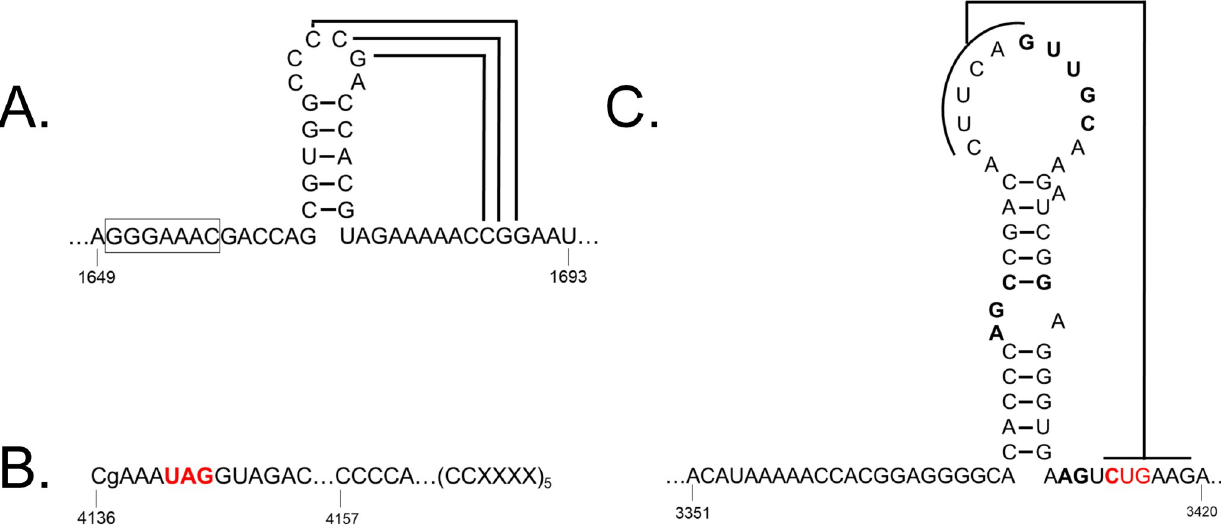
Fig 2. Proposed sites for ribosomal frameshift, ribosomal readthrough, and exoribonuclease-resistant RNA pseudoknot structure for Miscanthus yellow fleck virus. (A) Depiction of potential pseudoknot structure following the “slippery heptanucleotide” sequence (boxed), where ribosomal -1 frameshifting is proposed to occur, connecting open reading frame (ORF) 1 and 2. Drawing was modeled after that presented for sugarcane yellow leaf virus [27]. (B) Sequences flanking the potential readthrough stop codon site (in red), connecting ORFs 3 and 5. Uppercase letters indicate nucleotide residues and repeats flanking the stop codon that were previously shown to be conserved in Luteoviridae viruses [26]. X represents any nucleotide. (C) Predicted exoribonuclease-resistant RNA pseudoknot structure for Miscanthus yellow fleck virus that encompasses the internal-UTR. CUG start codon for ORF 3A is highlighted in red. The bolded nucleotides were those found to be conserved in Tombusviridae and Luteoviridae virus families